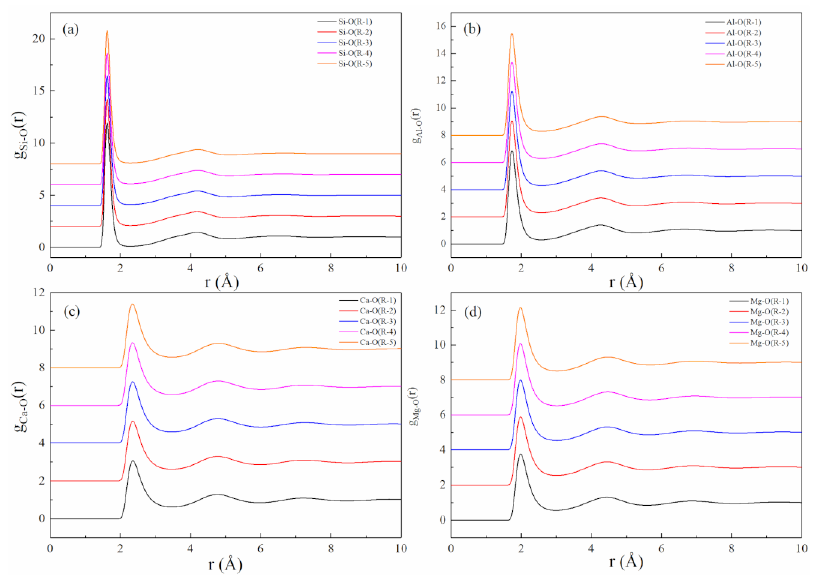
Figure 1. PDF of ( a ) Si-O, ( b ) Al-O, ( c ) Ca-O, and ( d ) Mg-O with various CaO/Al 2 O 3 ratios.